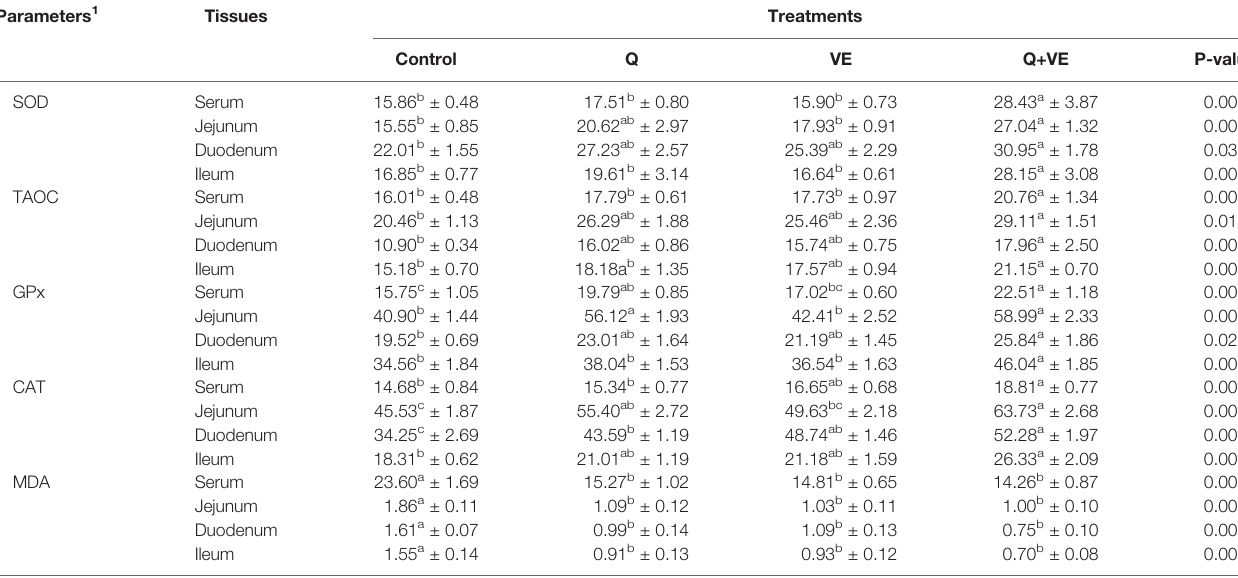
TABLE 2 | Effects of Q, VE, and Q + VE on antioxidant enzymes and MDA levels in the intestinal segments, and serum of aged breeder hens. Parameters